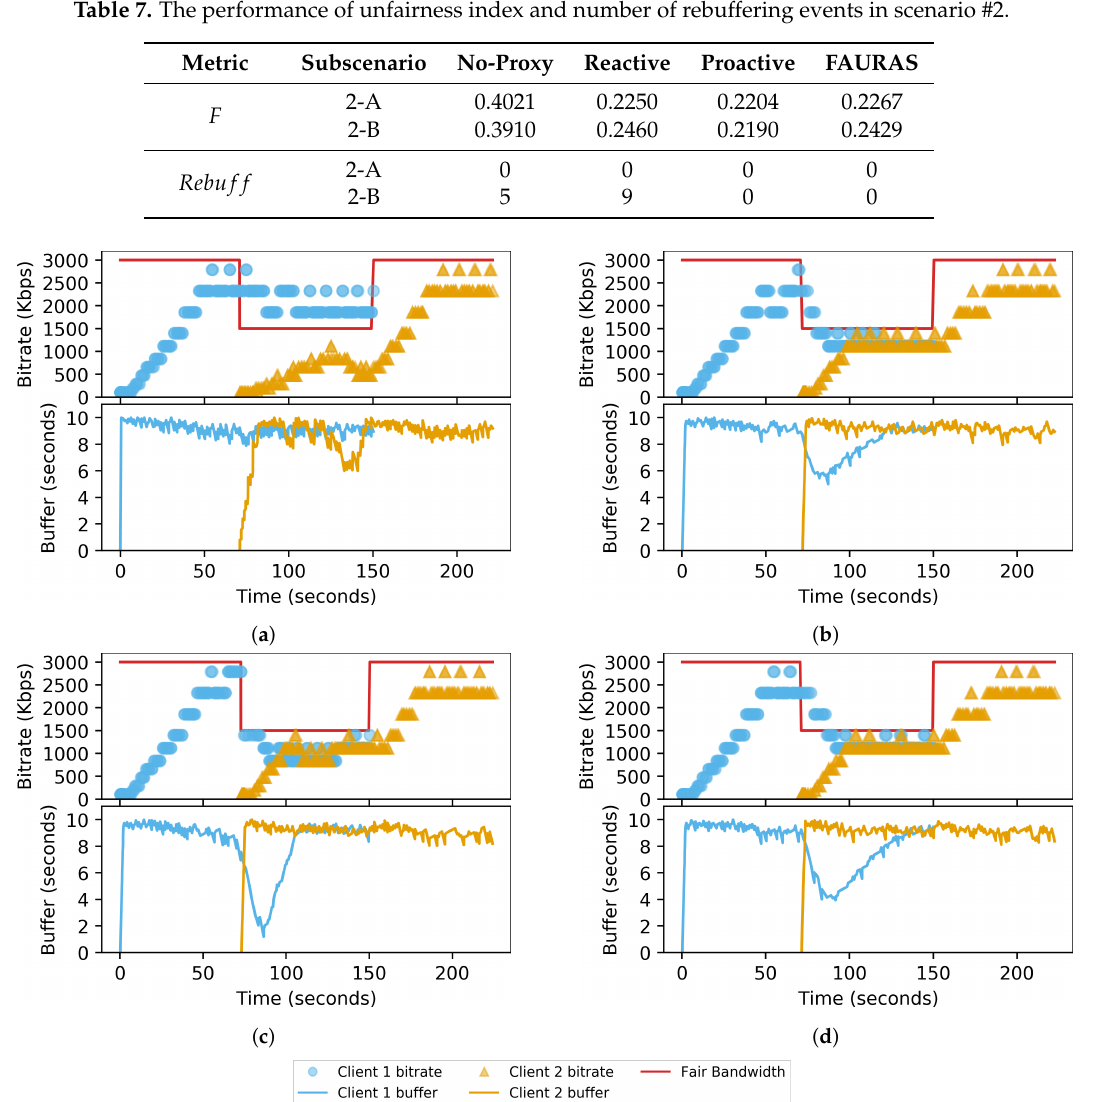
Table 7. The performance of unfairness index and number of rebuffering events in scenario #2.